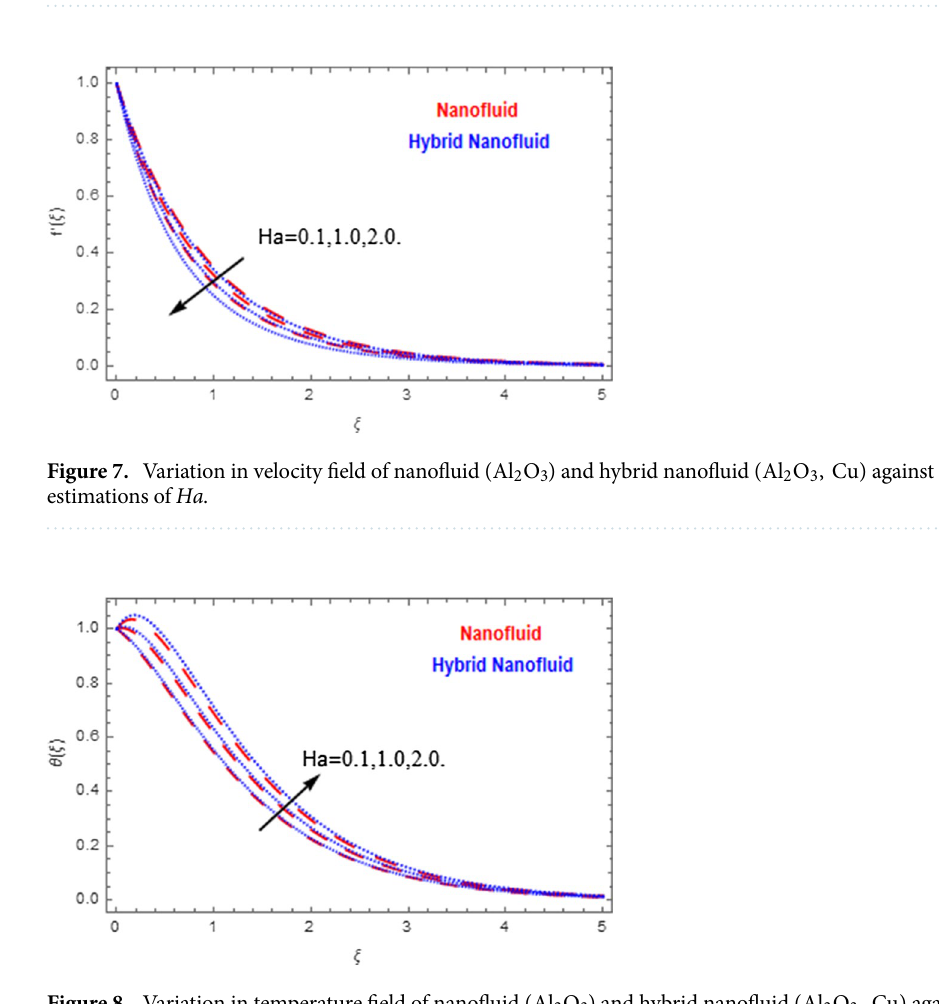
Table 2. Numerical association between HAM and Shooting techniques for velocity, micro-rotation, and temperature fields.